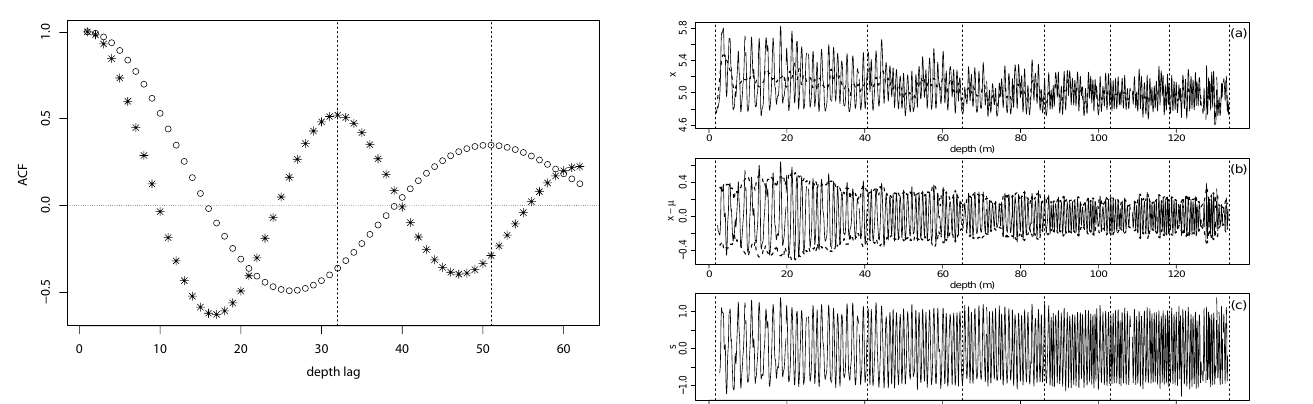
Fig. 1. The autocorrelation functions (ACFs) of the log H 2 O 2 from the second (circles) and fifth (stars) of the β = 6 sections of the Gomez ice-core, plotted against lag measured as a number of obser- vations. The vertical dashed lines indicate the local maxima of the ACFs, used to obtain an initial estimate of cycle length.